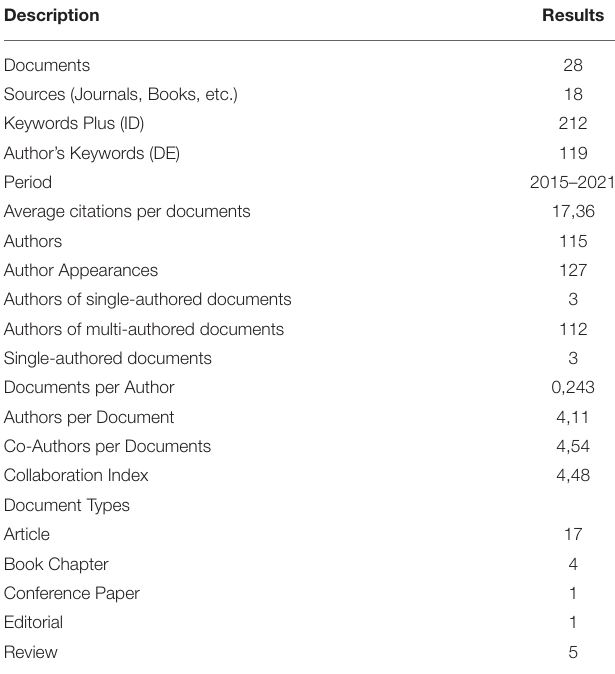
TABLE 1 | Information on the articles on WEF nexus used in this